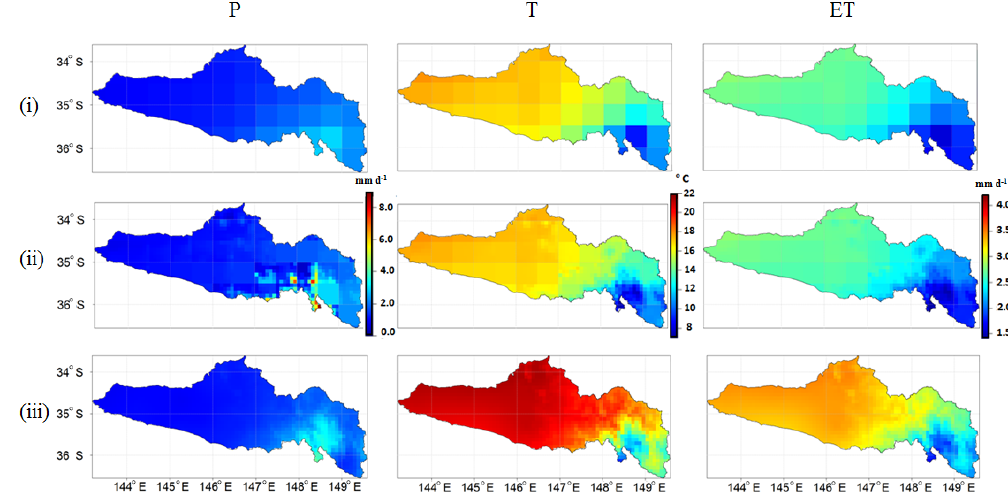
Figure 4. Daily mean precipitation, temperature and reference evapotranspiration for the time period 2007–2010 from the (i) global (0.5 ◦ × 0.5 ◦ ), (ii) downscaled global (0.08 ◦ × 0.08 ◦ ) and (iii) local (0.05 ◦ × 0.05 ◦ ) forcing data